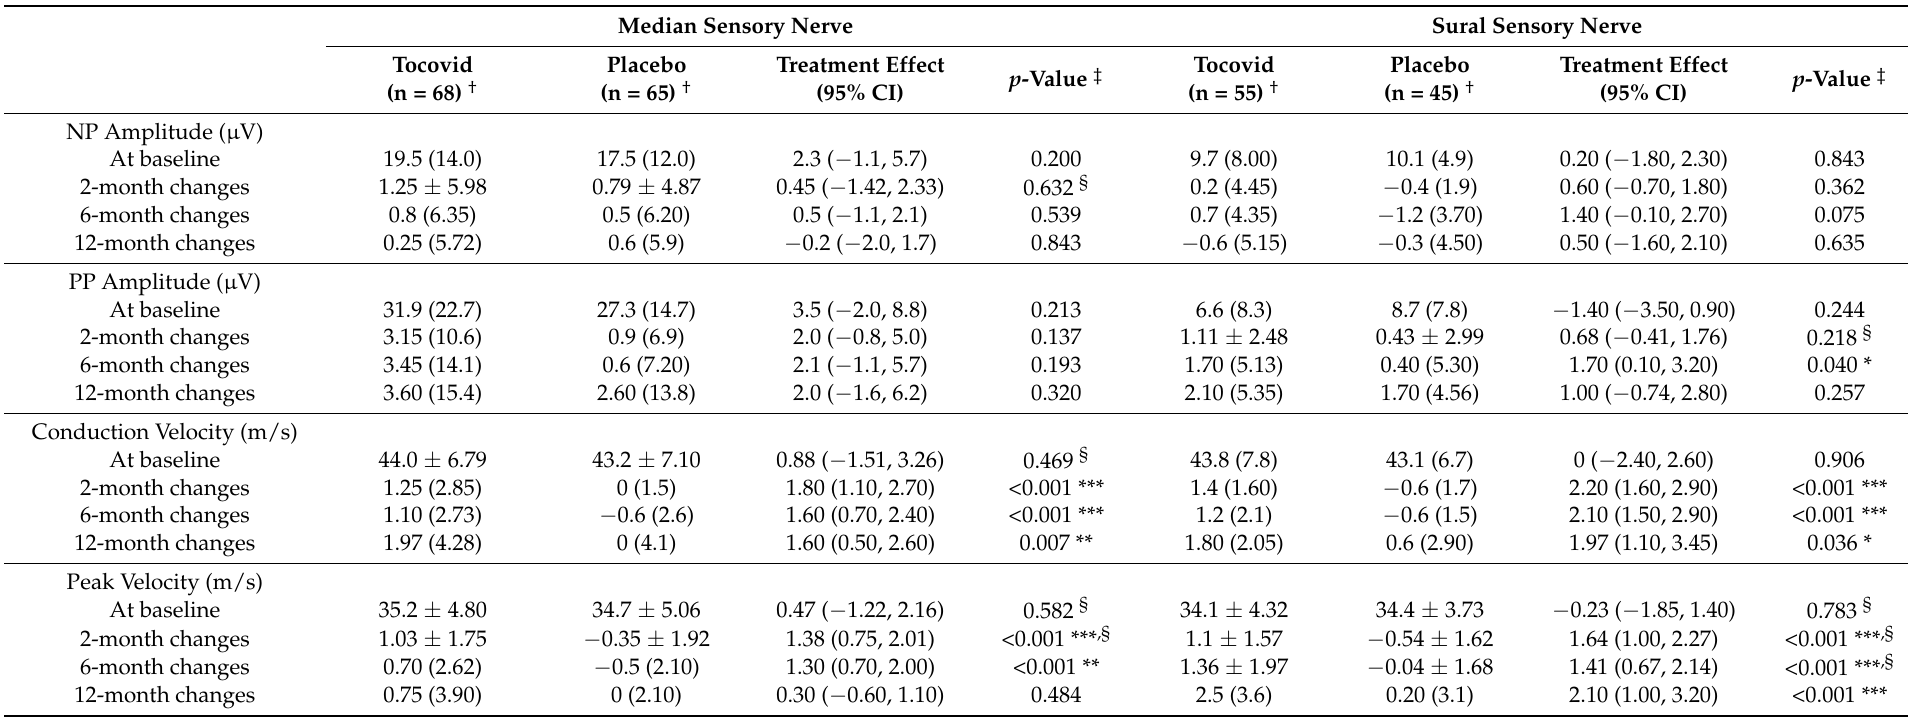
Table 3. Comparison of median and sural sensory nerve conduction parameters between Tocovid and placebo